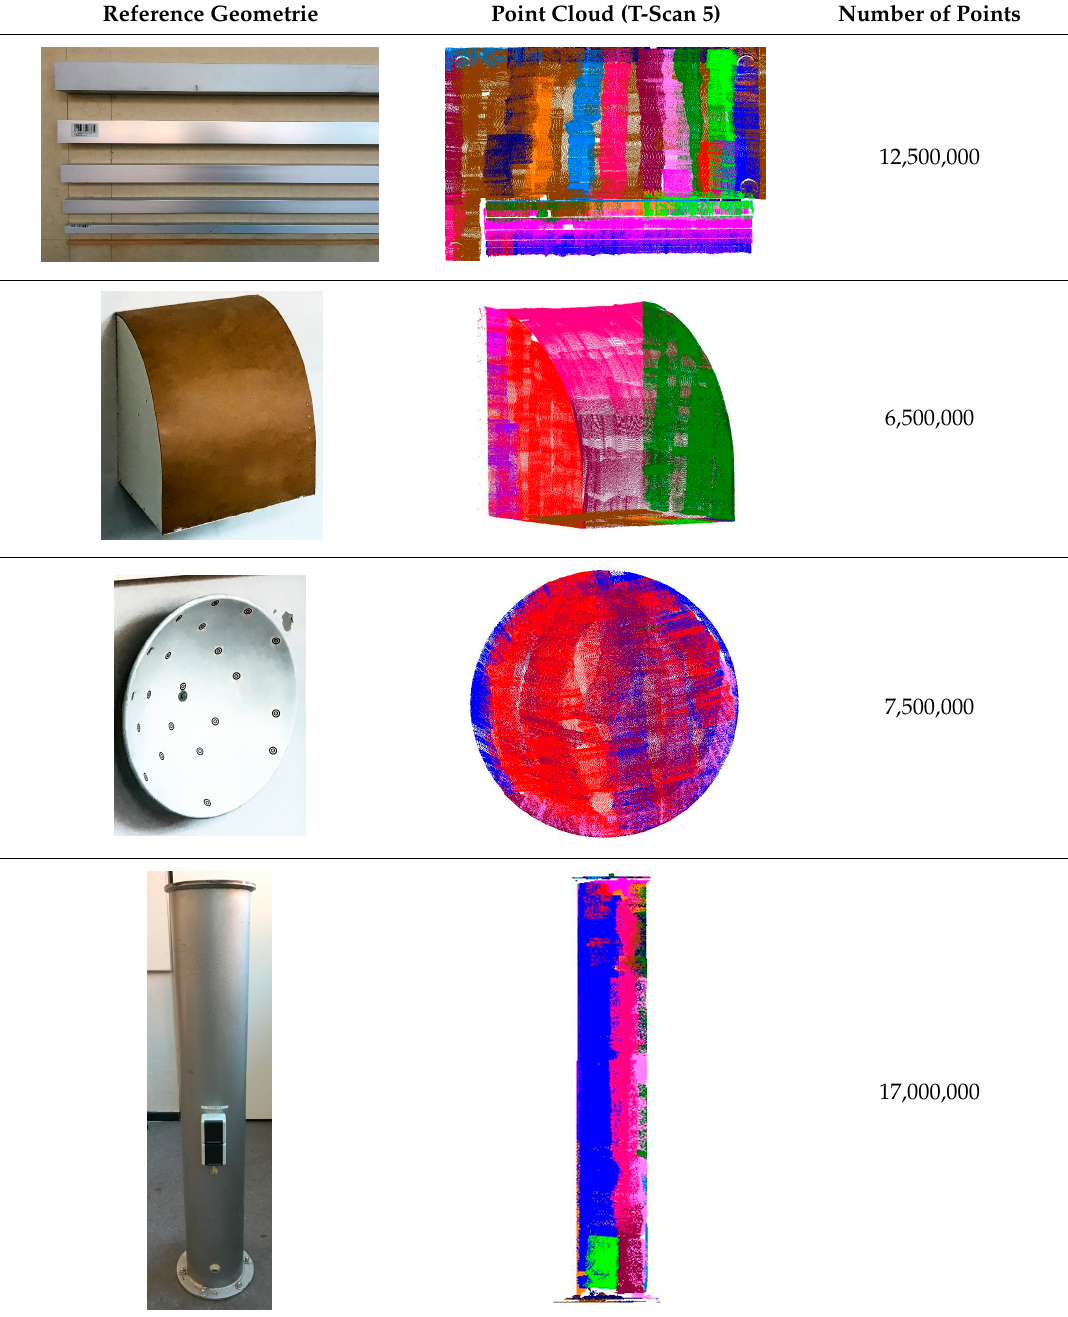
Table 4. Number of points for reference geometries scanned with T-Scan 5.